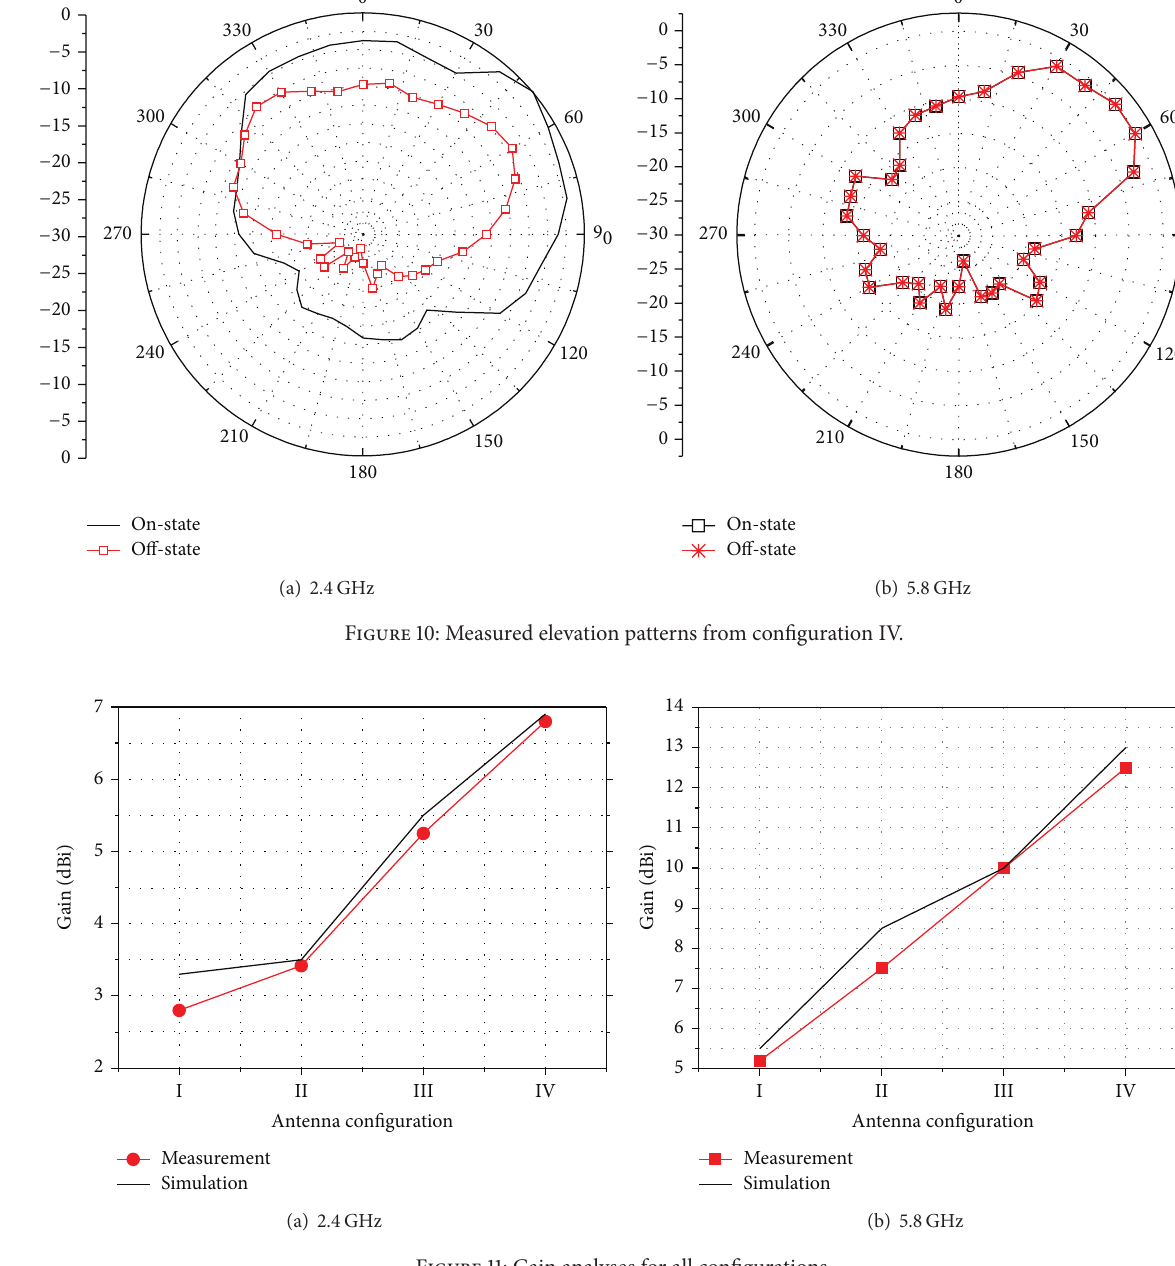
Figure 11: Gain analyses for all